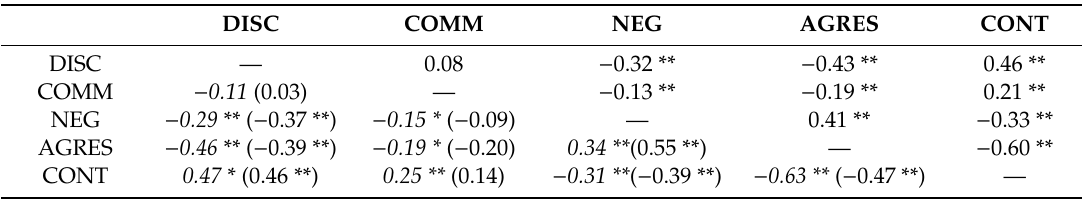
Table 4. Correlations in the total sample (above diagonal) and by gender (below diagonal) for the 3–6 year-old